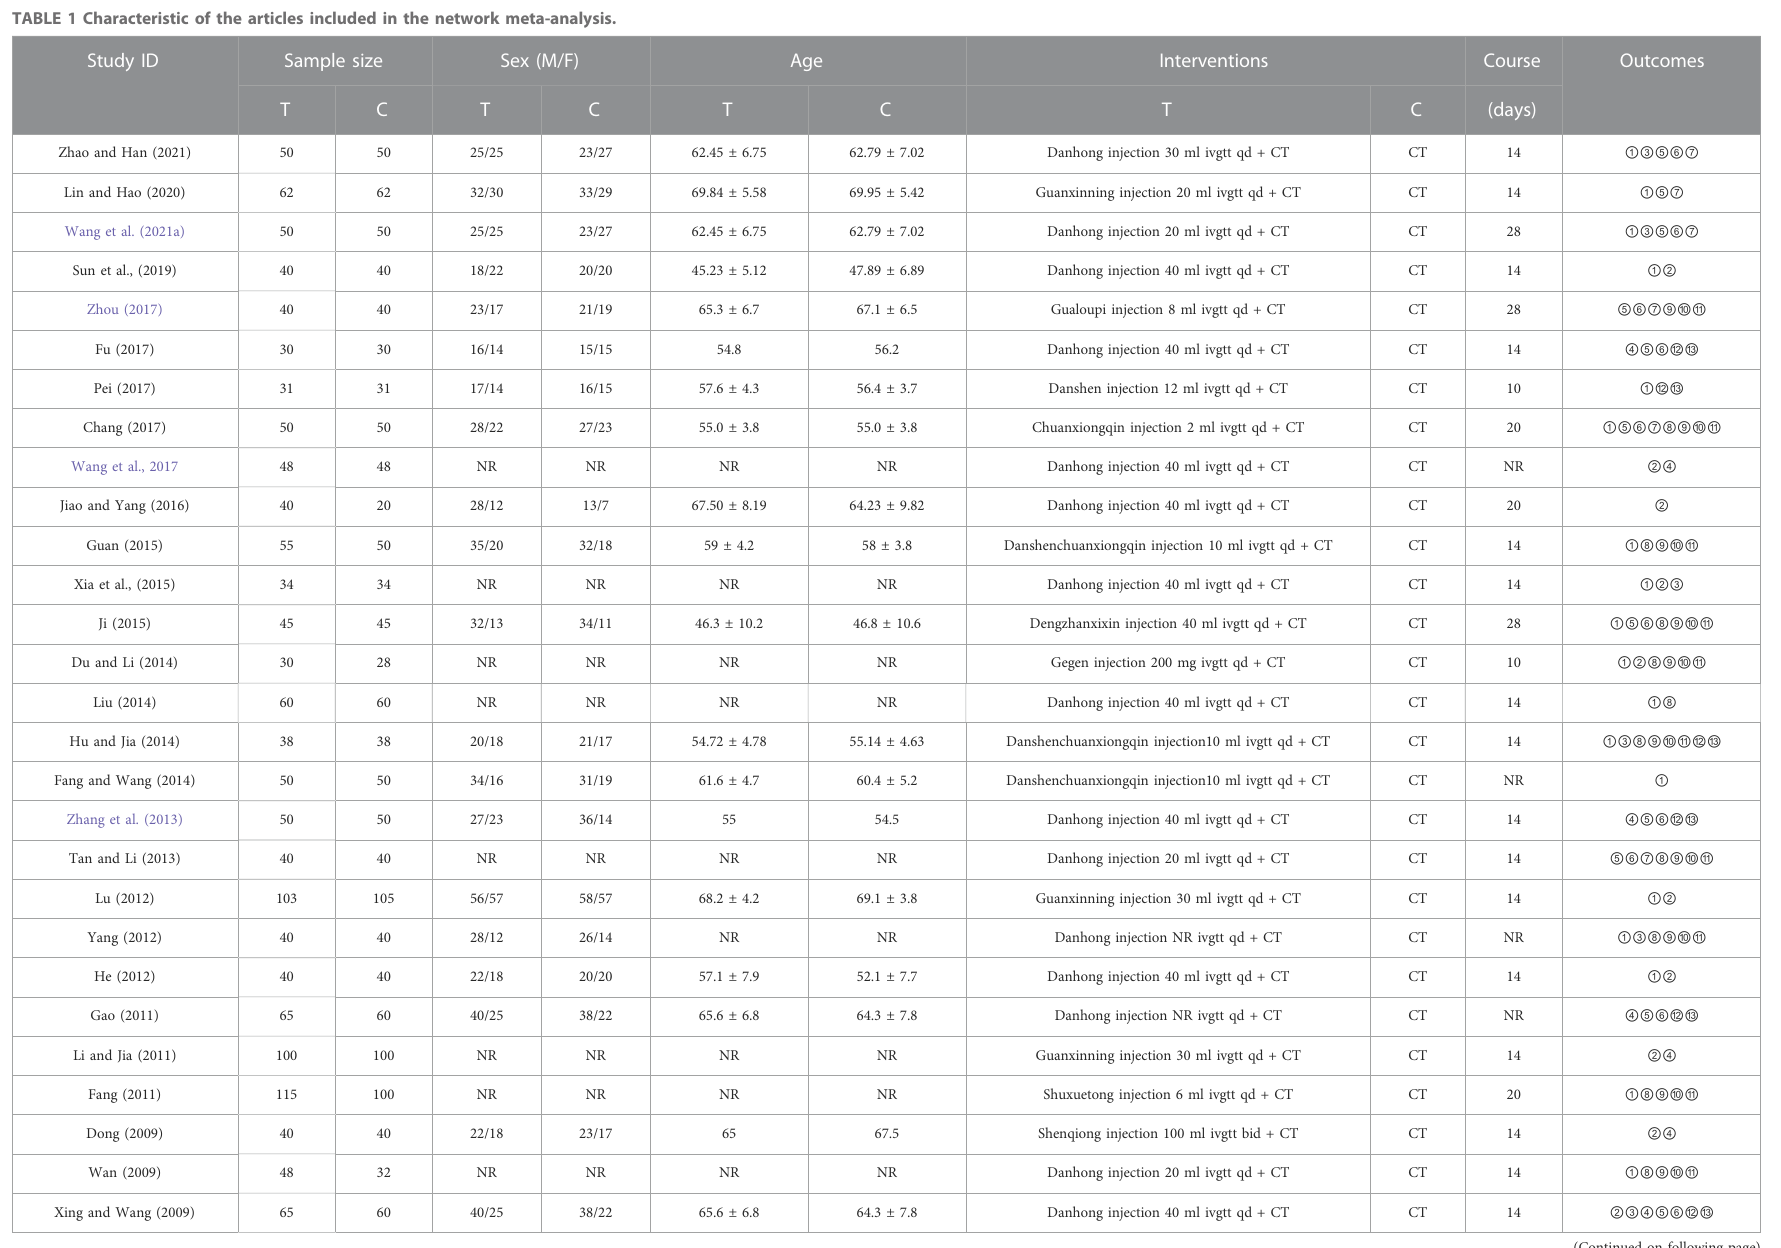
TABLE 1 Characteristic of the articles included in the network